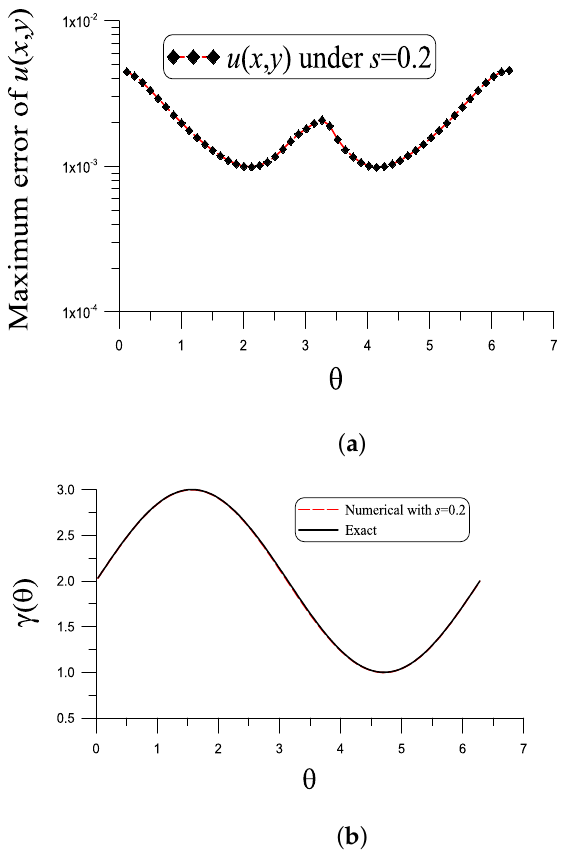
Figure 6. For example 5, showing ( a ) the error in the numerical recovery of u and ( b ) comparing the numerical recovery of γ under a noise s =